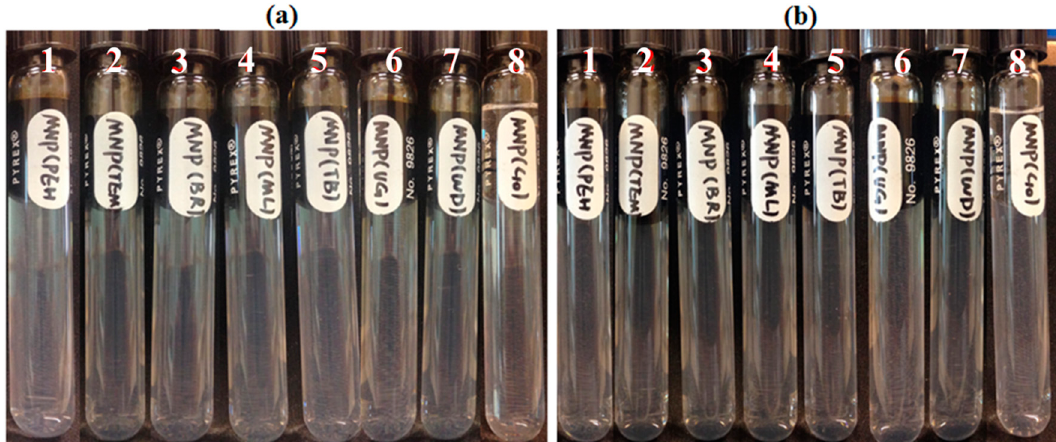
Figure 13. FNP-MD suspensions stability screening with different type of oils: ( a ), Day 1; ( b ), Day 30;